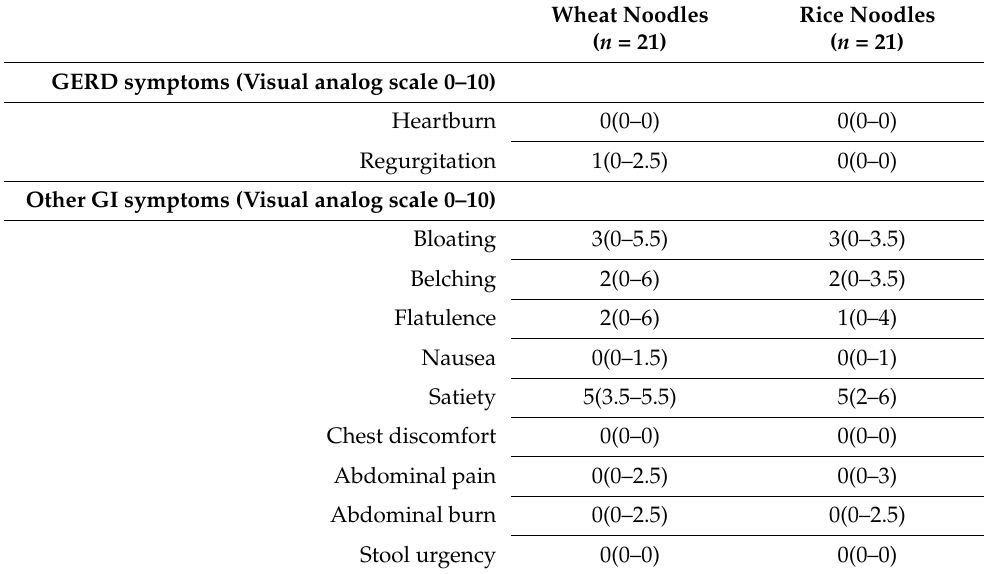
Table 1. Fasting gastrointestinal symptom scores in the morning before each study meal ingestion. Wheat